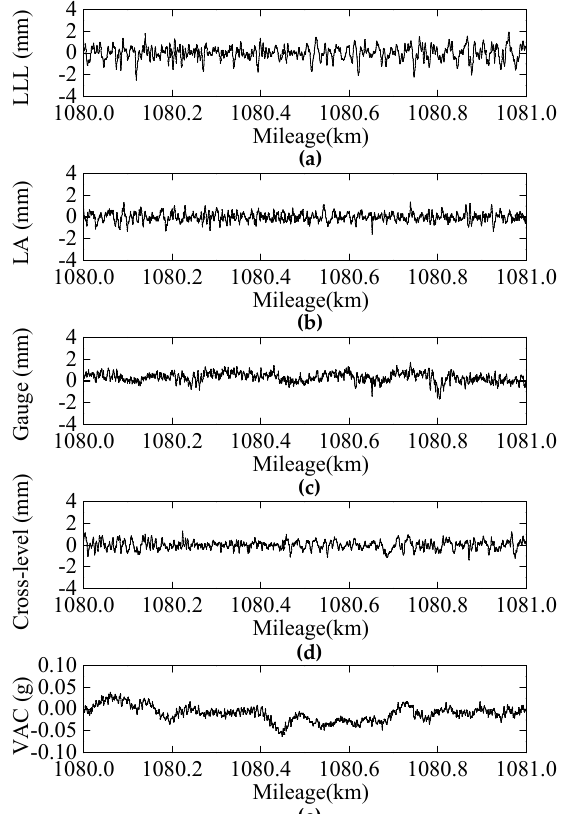
Figure 3. Inspection items of the test line. ( a ) LLL; ( b ) LA; ( c ) Gauge; ( d ) Cross-level; ( e ) VAC.